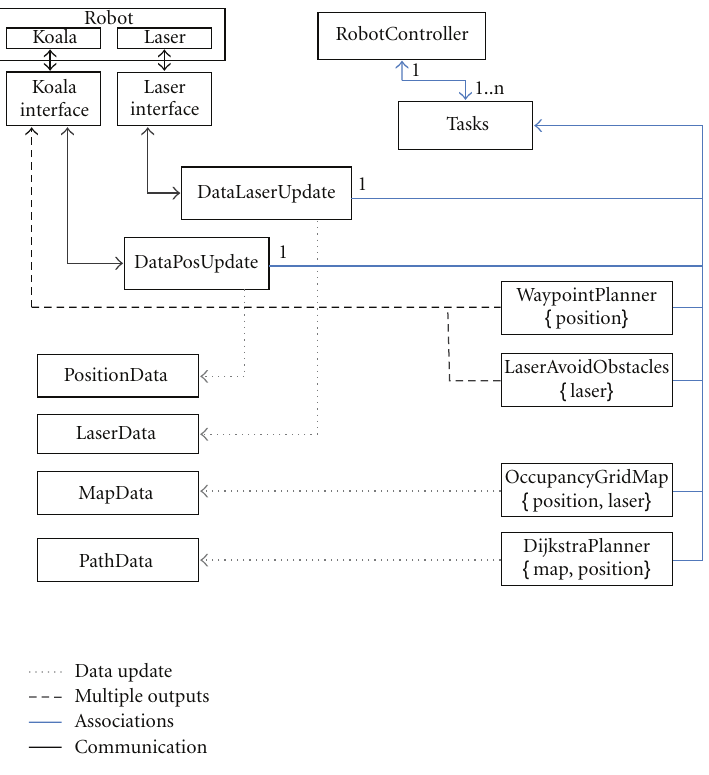
Figure 1: Framework for the robot